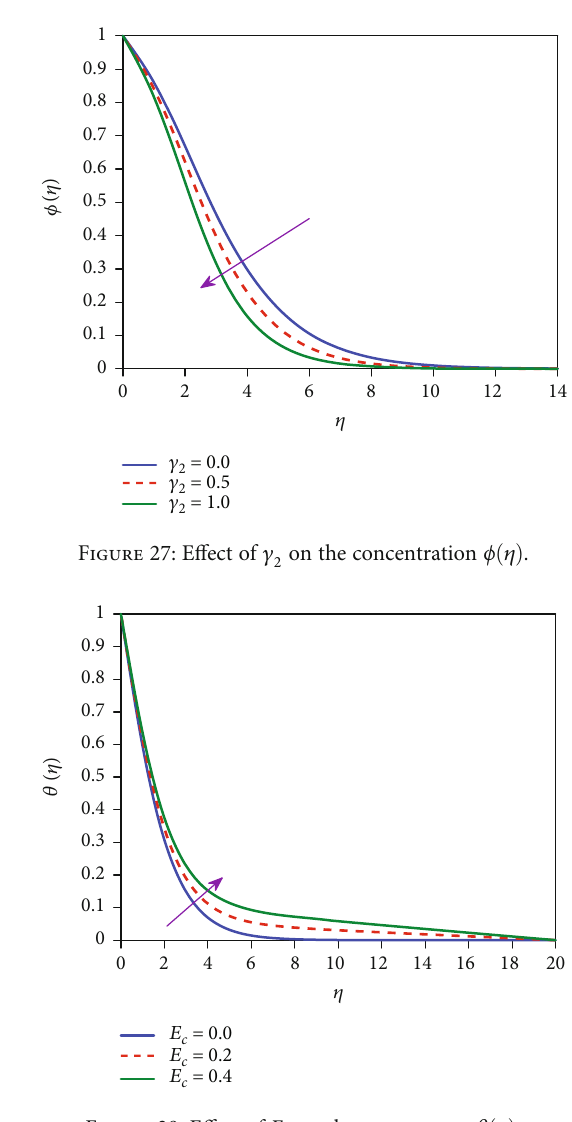
Figure 28: E ff ect of Ec on the temperature θ ð η Þ .